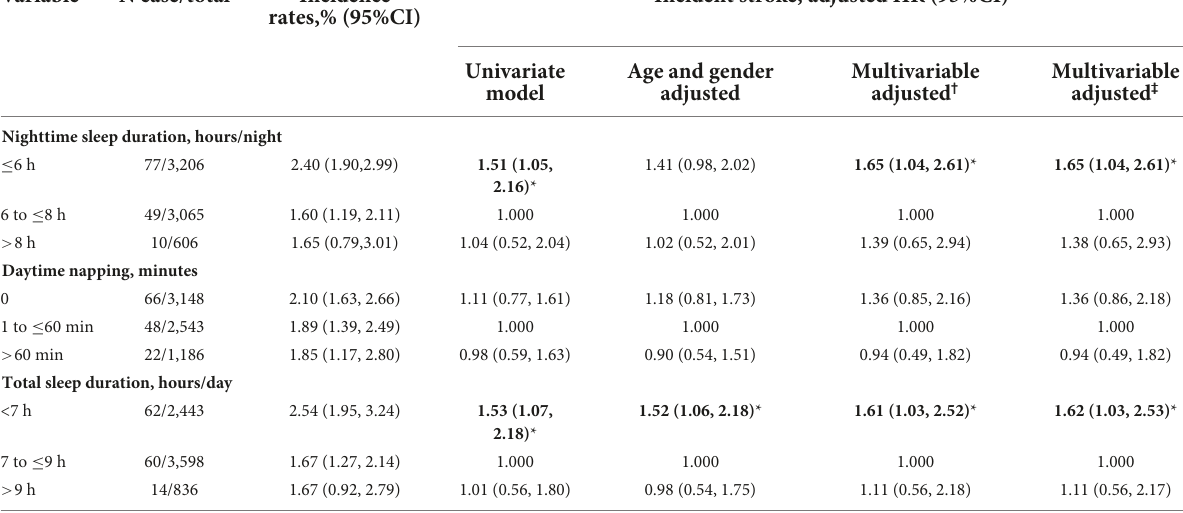
TABLE 3 Hazard ratios (95%CI) of incident stroke by sleep duration and daytime napping.